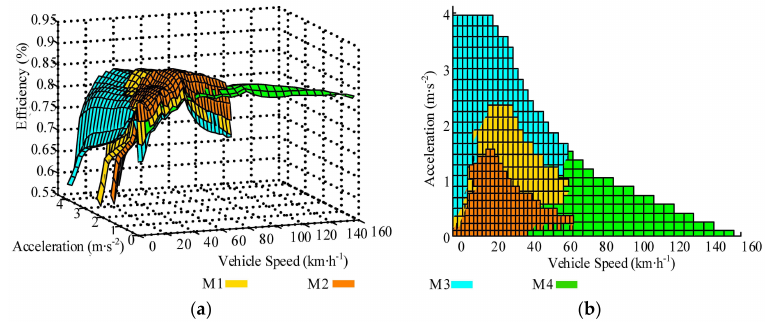
Figure 3. ( a ) System efficiency maps of the four modes; and, ( b ) Operating boundaries of the four modes.